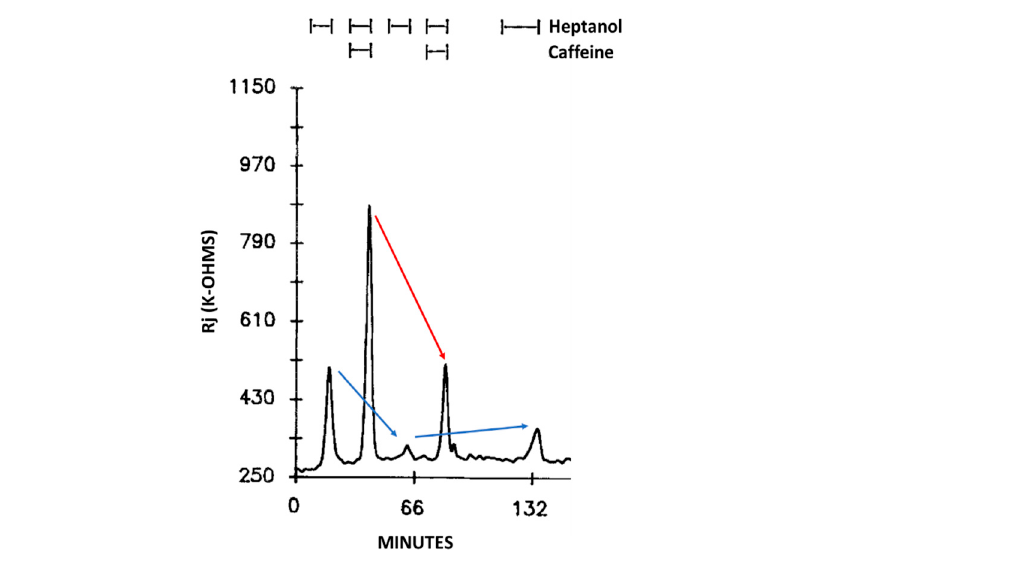
Figure 4. Time course of Rj changes in crayfish axons uncoupled by heptanol in the presence or absence of caffeine. Note the difference in Rj maxima between first and third uncoupling events (left blue arrow), in spite of the same duration of heptanol superfusion (8 min). Similarly, the Rj maxima decrease in the presence of heptanol-caffeine (compare second and forth uncoupling events; red arrow). The heptanol effect on Rj partially recovers (see 5th event, right blue arrow). The drop in Rj maxima in the 2nd and 4th event may indicate the first heptanol and heptanol-caffeine treatments lowered the Ca 2+ content of the Ca 2+ stores. Adapted from [16].